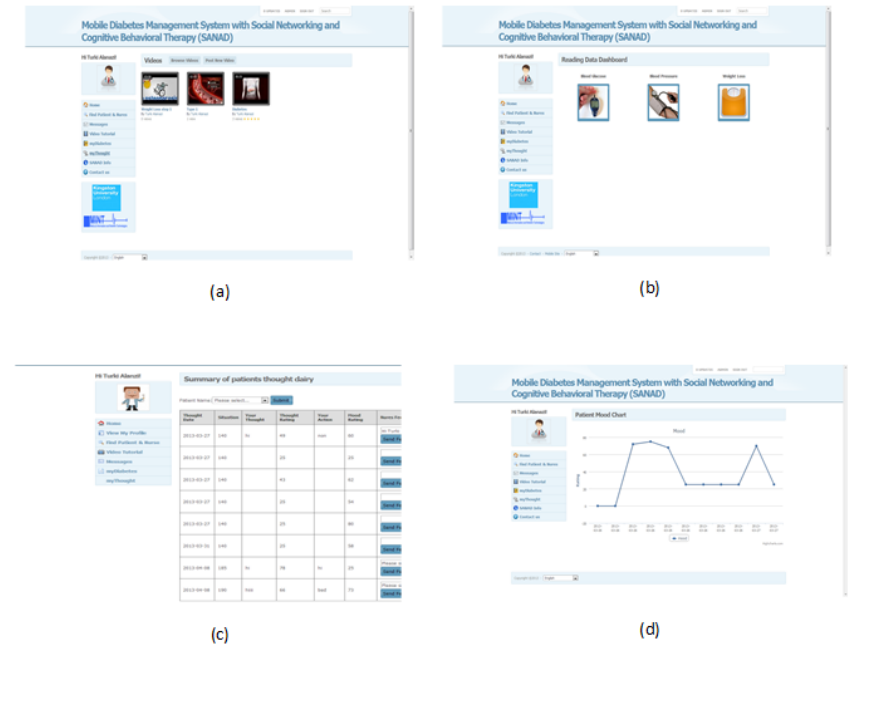
Figure 5. Snapshots of the diabetes nurse portal interface end (top panel) and snapshots of cognitive behavioral therapist’s portal interface end (bottom panel) in the Saudi Arabia Networking for Aiding Diabetes (SANAD)